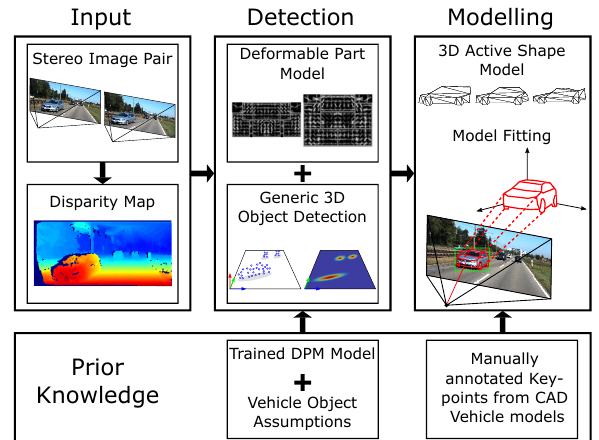
Figure 1. High-level overview of our